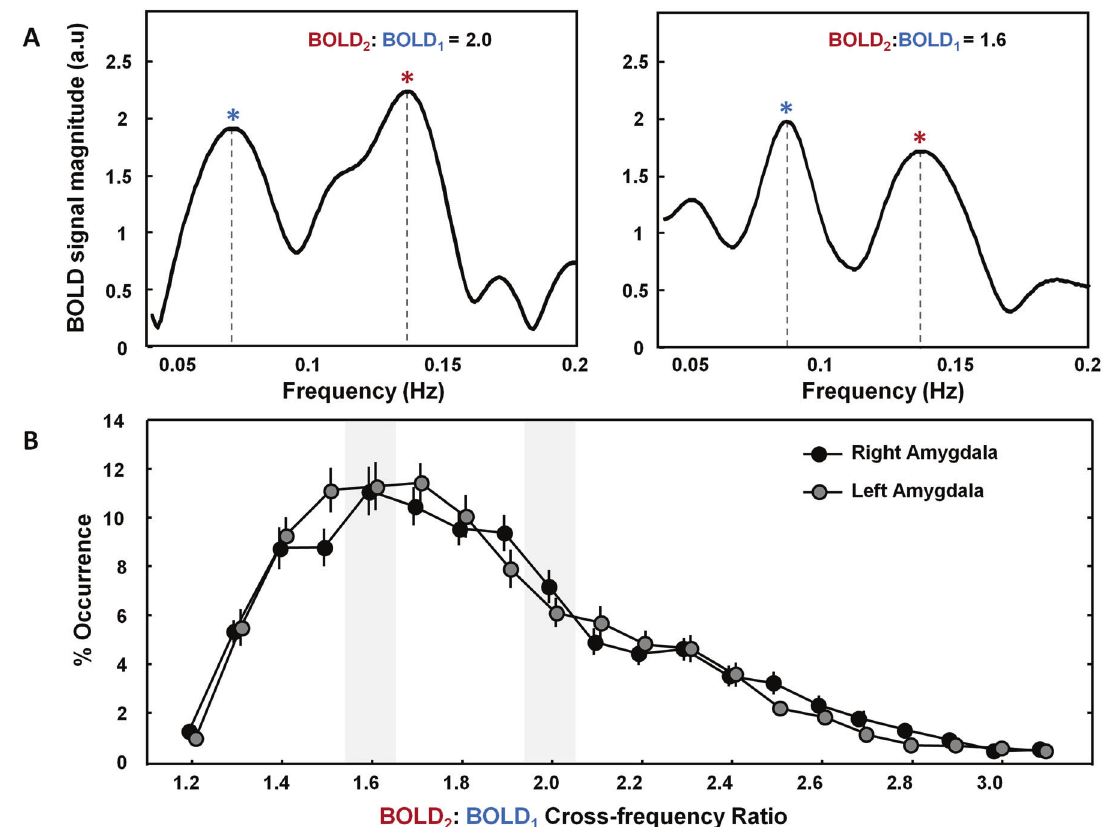
Fig. 1 Transient detection of BOLD1 and BOLD2 peak frequencies and determination of cross-frequency relationships. Peak frequencies of BOLD oscillatory components, with frequency ranges 0.05 – 0.1 Hz (BOLD1) and 0.1 – 0.17 Hz (BOLD2) were detected transiently, and the numerical ratio between the BOLD2 and BOLD1 peak frequencies was calculated (peak-frequency BOLD2 /peak-frequency BOLD2 ). A Visualization of the BOLD frequency spectra of two exemplary windows in which the identi fi ed BOLD2 and BOLD1 peak frequencies formed a “ harmonic ” (2:1) versus a “ non-harmonic ” (1.6:1) cross-frequency relationship. B Visualization of the relative occurrence of all possible cross-frequency relationships (% occurrence) as recorded at baseline (before nasal-spray administration), showing a maximal occurrence of the non-harmonic 1.6:1 BOLD2:BOLD1 ratio aspect both in the right and left amygdala (occurrence of respectively, 11.3% and 11.1%, average across participants). The harmonic 2:1 ratio aspect showed an average occurrence of 4.7% in the right and 5.8% in the left amygdala detected for each BOLD frequency band within each overlapping Hanning window using the fi nd local maxima function, implemented in MATLAB r2020b (i.e., fi ndpeaks ) (similar to procedures described in refs. [32, 36]). With this algorithm, data samples larger than their two neighboring samples are identi fi ed as “ local peaks ” within the speci fi ed spectral frequency range of each BOLD component. For a limited number of windows, no clear peaks were detected, and these windows were excluded from further analyses (BOLD1: 8.87%; BOLD2: 2.11% of the total number of windows, across participants and sessions). When two or more peaks were detected in one frequency band, only the peak with the highest amplitude was selected. Mean peak frequencies of each frequency component were obtained separately for each participant, ROI, and session. Calculation of regional BOLD harmonic and non-harmonic cross-frequency interactions . Cross-frequency harmonic and non-harmonic relationships between transient peak frequencies were assessed for the left and right amygdala ROI. To do so, the numerical ratio of the BOLD1 and BOLD2 peaks (peak-frequency BOLD2 / peak-frequency BOLD1 ) was calculated for each window and rounded to the fi rst decimal place (e.g., 0.14/0.07 Hz = 2.0). Hence, the obtained ratio values ranged between 1.1 and 3.2 in steps of 0.1. Next, the proportion of windows in which the BOLD2:BOLD1 peak ratio equaled 1.6 or 2.0, respectively, representing non-harmonic and harmonic relationships, was determined for each participant, ROI, and session. Figure 1A visualizes the FFT frequency spectra of two exemplary windows in which the identi fi ed BOLD2 and BOLD1 peak frequencies formed a “ harmonic ” (2:1) versus a “ non-harmonic ” (1.6:1) cross-frequency relationship. Figure 1B visualizes the distribution of the percentage occurrence of all possible ratios, as recorded at the baseline session,